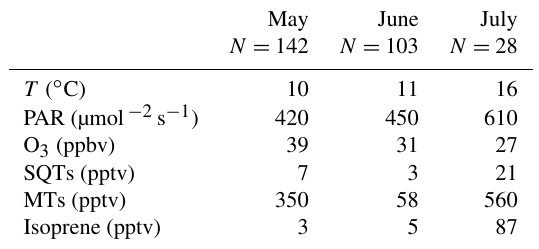
Figure 8. An estimate of the potential importance of emissions of different BVOC groups for SOA production. For calculating the SOA flux, BVOC emissions were weighted by the mean SOA yields found by Lee et al. (2006) in photo-oxidation chamber studies (SQT 68%, MT 32% and isoprene 2%). F1(a): frame 1 in 29 May– 4 June; F2: frame 2 in 6–7 June; F1(b): frame 1 in 4–10 July; F3: frame 12–13 July; F1(T): tube samples from frame 1 in 30 July– 2 August.